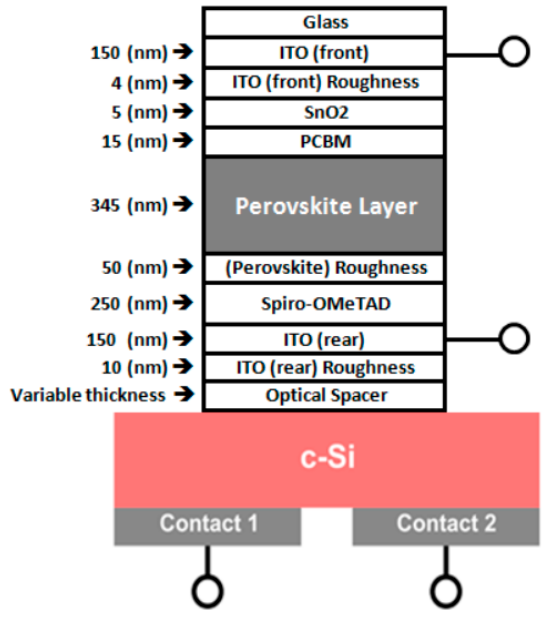
Figure 1. Device structures of the four-terminal perovskite/silicon tandem solar cell are shown.